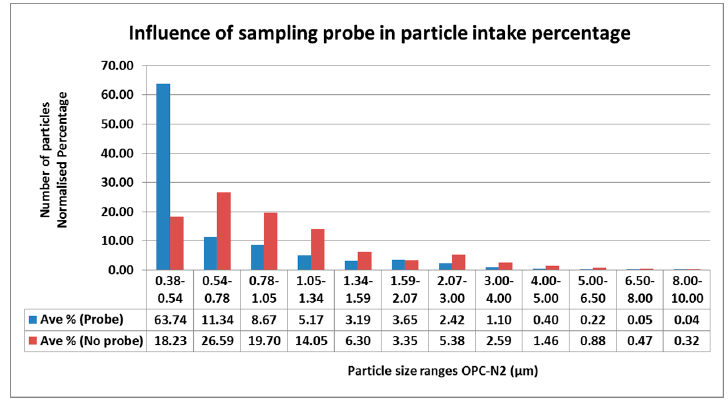
Figure 10. Influence of the sampling probe used with the OPC-N2 over particle counting readings per particle size range.